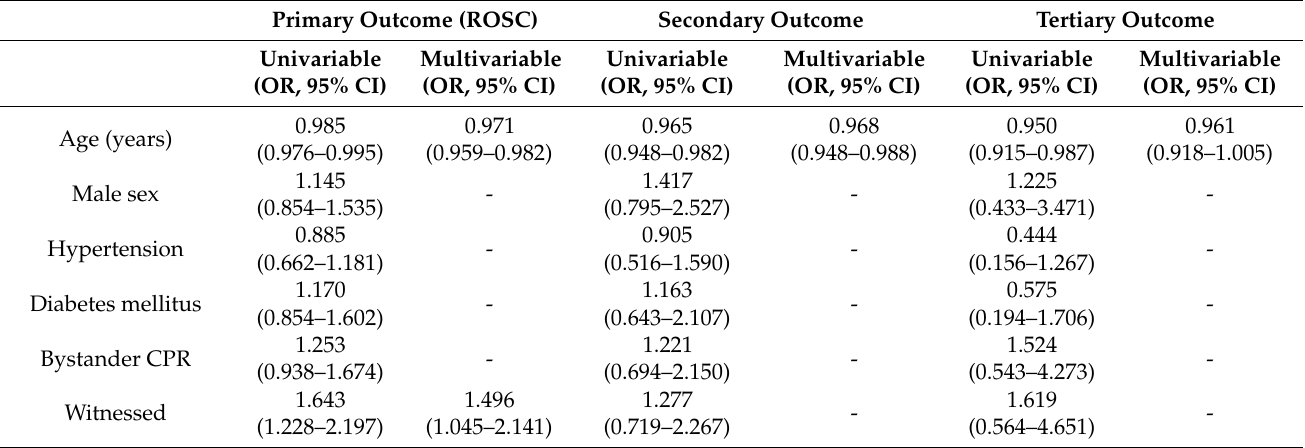
Table 2. Association of LDH level with clinical